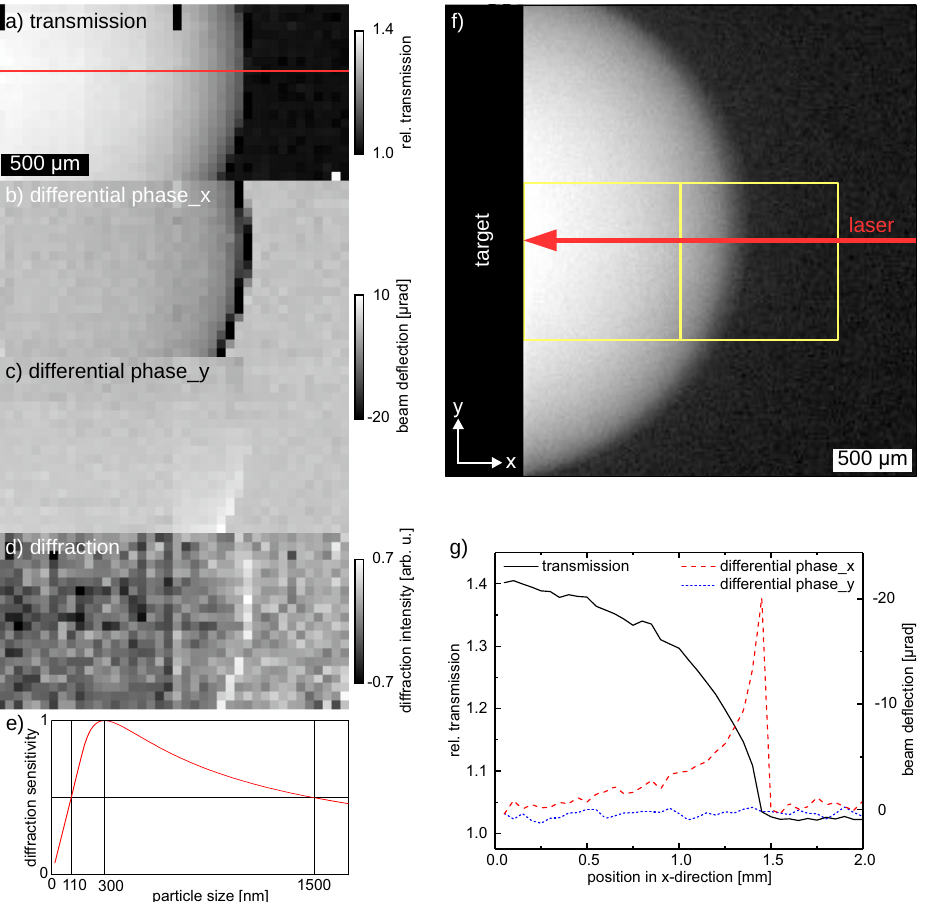
Figure 5. Results of a multi-contrast imaging of a transient cavitation bubble during ablation under liquid at its maximum expansion. Two separate measurements were repeated at two selected positions relative to the bubble, as indicated in the bright-field radiogram in ( f ) and merged after reconstruction. ( a – d ) show the different contrasts after averaging over 700 individual exposures of 33 µ s each. Note that the diffraction is the mean of the two directional values as no anisotropic scattering is expected. The graph in ( e ) shows the calculated sensitivity curve on scattering particle size. The graph in ( g ) shows clearly the correspondence of transmission and differential phase (shown in beam deflection) as function of bubble height above the